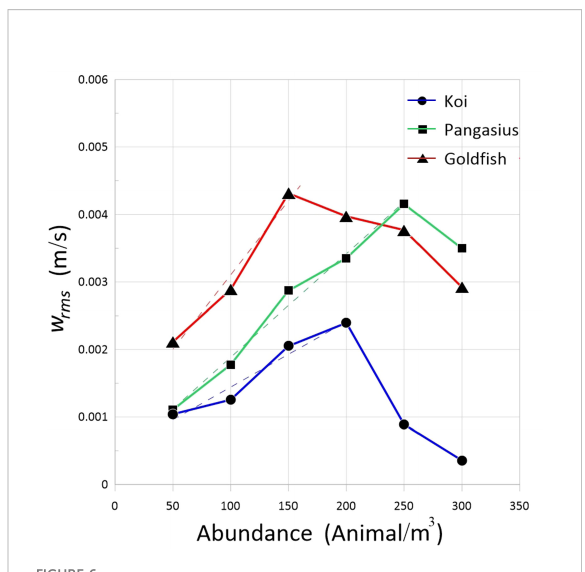
FIGURE 6 RMS velocities of the fl ow generated by the schools of koi, pangasius, and gold fi sh as a function of abundance. The broken lines are least-squares linear regressions fi tted to the data.